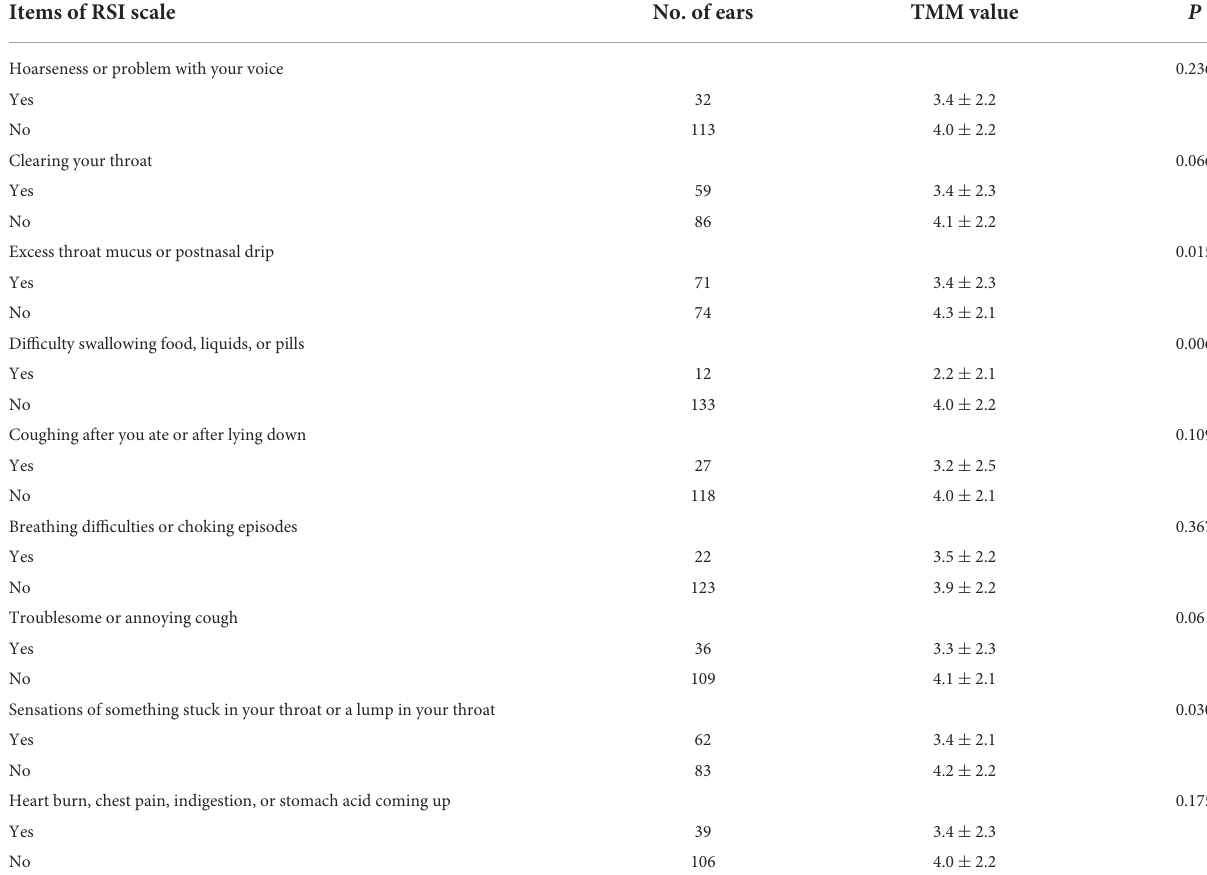
TABLE 3 The comparison of TMM value between ears with different RSI symptoms. Items of RSI scale No. of